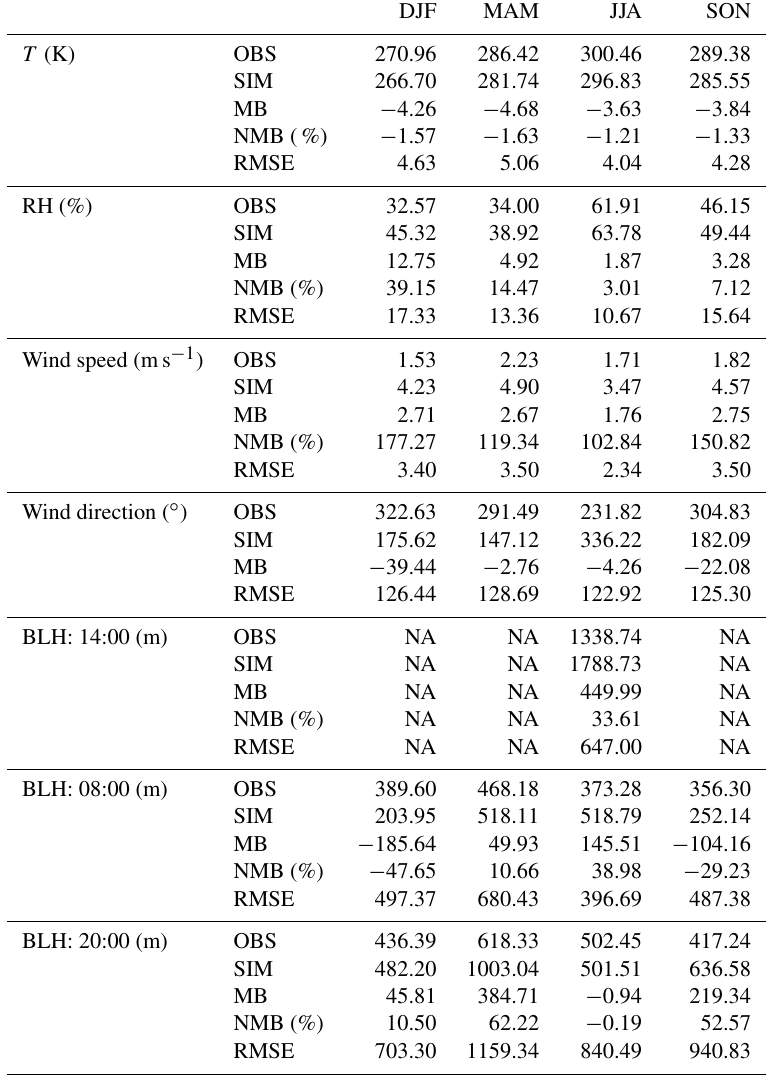
Table 1. Comparisons of the observed and simulated meteorological parameters, including T , RH, wind speed, wind direction, and BLH, for the four seasons during the period of July 2011 to May 2013 at the PKUERS site. “OBS” and “SIM” represent the mean values of the observations and simulations,